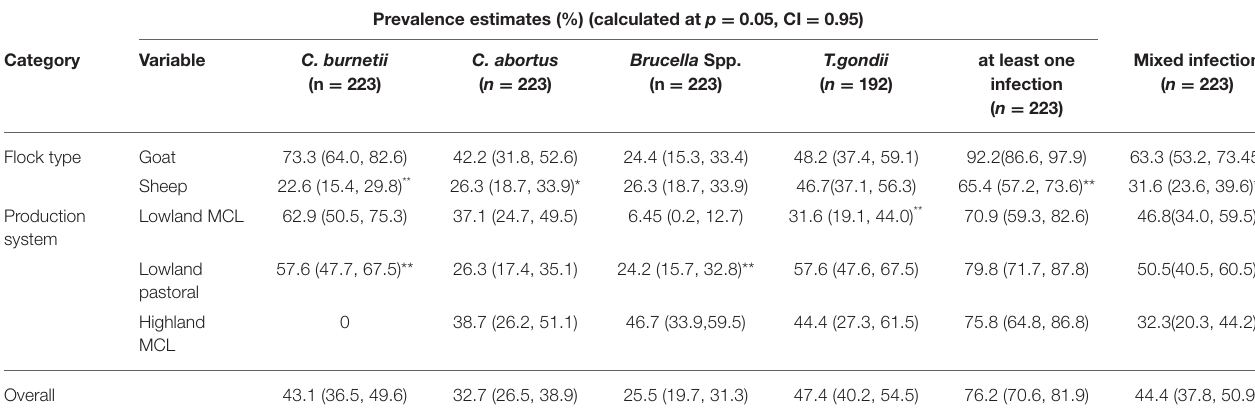
TABLE 4 | Flock level seroprevalence of major infectious causes abortion in small ruminant in three agroecology and production systems of